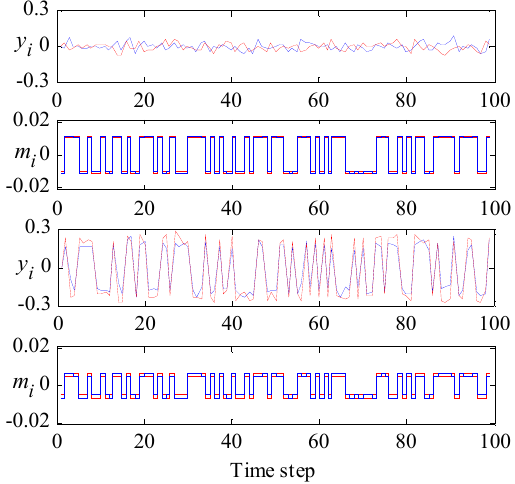
Figure 8. Outputs, y i , and inputs, m i ( i = 1,2), for IC optimal design when χ = 1 (top two rows) and χ = 0 (bottom two